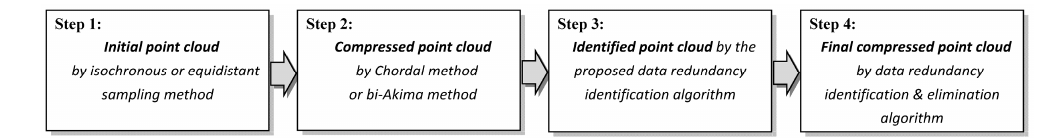
Figure 1. The overall process of on-line data compression for 3D free-form surface scanning measurement.